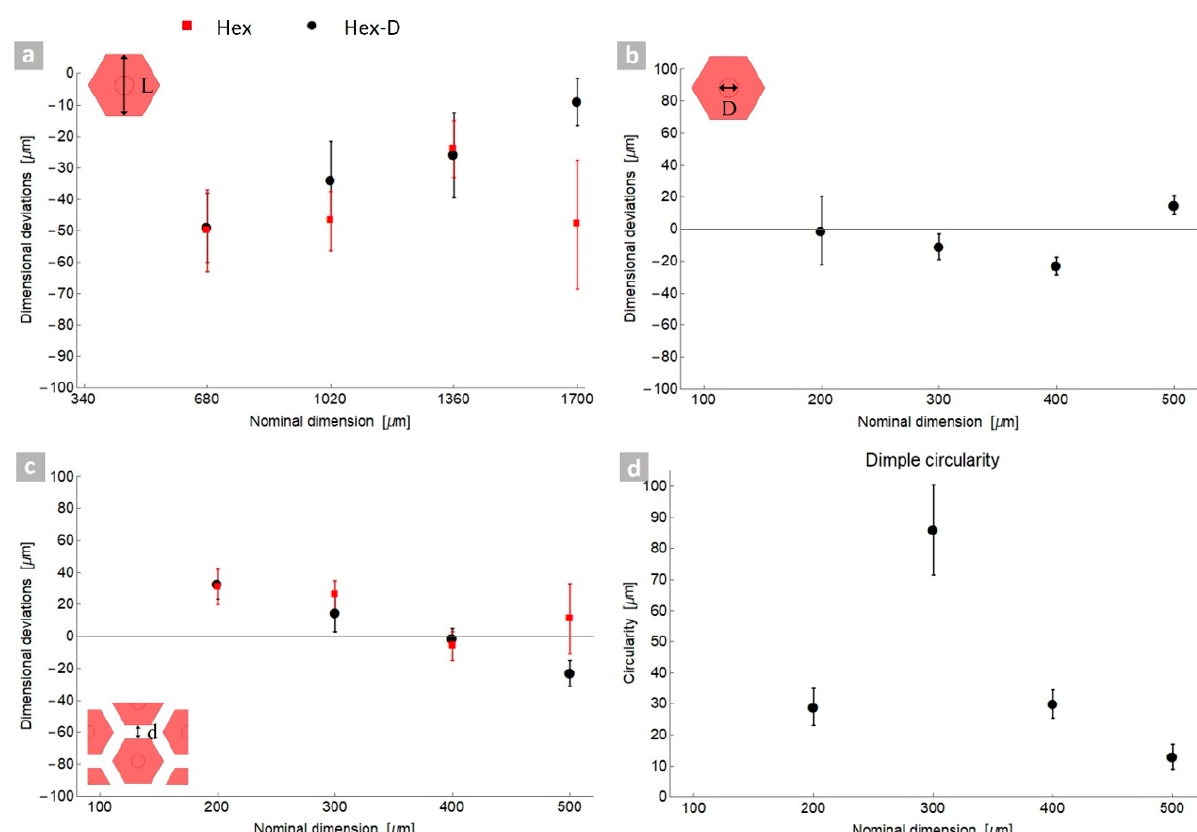
Figure 4. Dimensional deviations in printed structures as obtained using a CNC measuring system related to ( a ) twice hexagon apothem L , ( b ) dimple diameter D , ( c ) gap d between adjacent prisms, ( d ) dimple circularity.